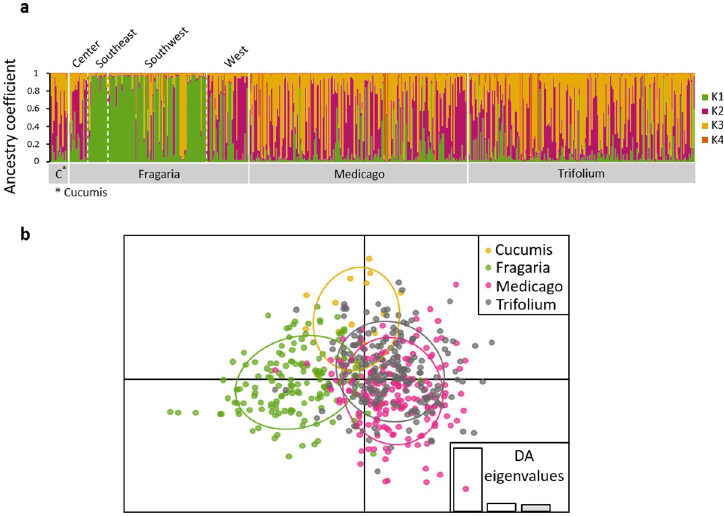
Fig 4. Genetic structure of wild Aphidius ervi based on seven microsatellite loci: (a) inference of population structure using Bayesian clustering with the program STRUCTURE (K = 4, the most probable number of clusters is presented, coefficient of ancestry is an average on ten runs) and (b) Discriminant Analysis of Principal Components according to the host plant on which individuals were collected. Putative populations are distinguished by colors and inertia ellipses.